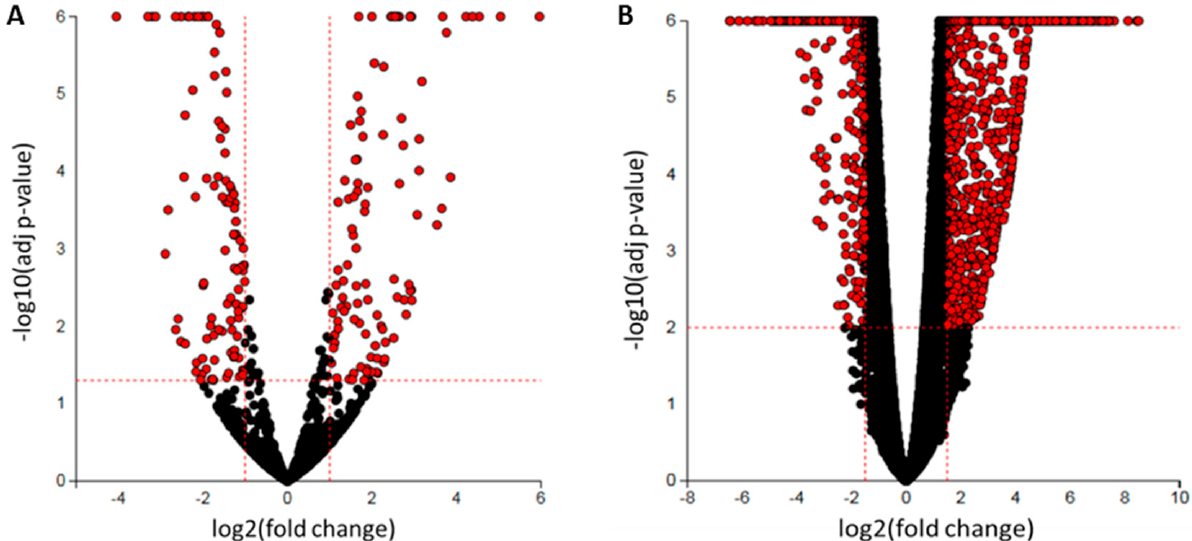
Figure 1. Volcano plots representing the differential expression of butyrate responsive miRNAs and protein-coding genes in HCT116 colorectal cancer (CRC) cells. The x -axis represents the differential expression (log2-fold change (FC)), and the y -axis represents the significance (–log10 ( p -value)): ( A ) small RNA sequencing was performed to determine differential miRNA expression. Selection criteria: log2FC ≤ − 1 or log2FC ≥ 1 and adj p -value < 0.05, ( B ) Total RNA sequencing was performed to determine differential protein-coding gene expression. Selection criteria: log2FC ≤ − 1.5 or log2FC ≥ 1.5 and adj p -value < 0.01. Statistically significant differentially expressed miRNAs or protein-coding genes are colored in red, while black dots show those with no significant change. The plot was generated using the Advaita iPathway Guide tool [20] .